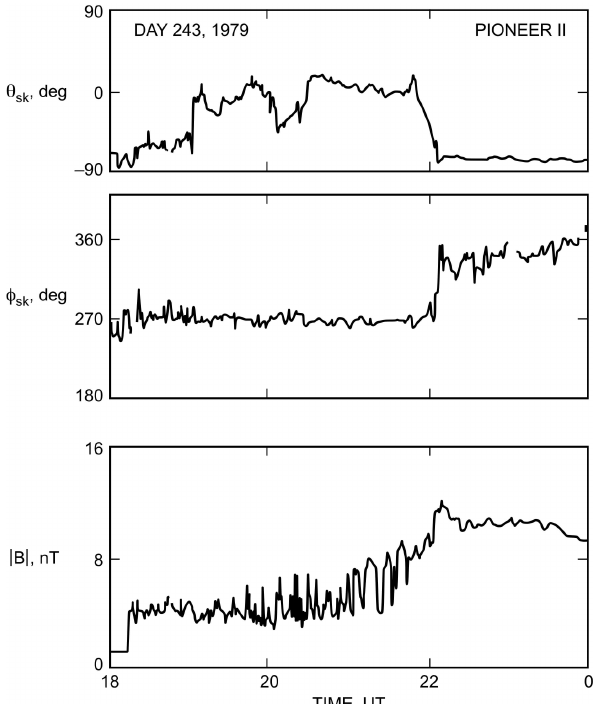
Figure 12 Fig. 13. Mirror mode structures in Saturn’s magnetosheath. Note that the amplitudes are small or nonexistent near the shock and largest near the